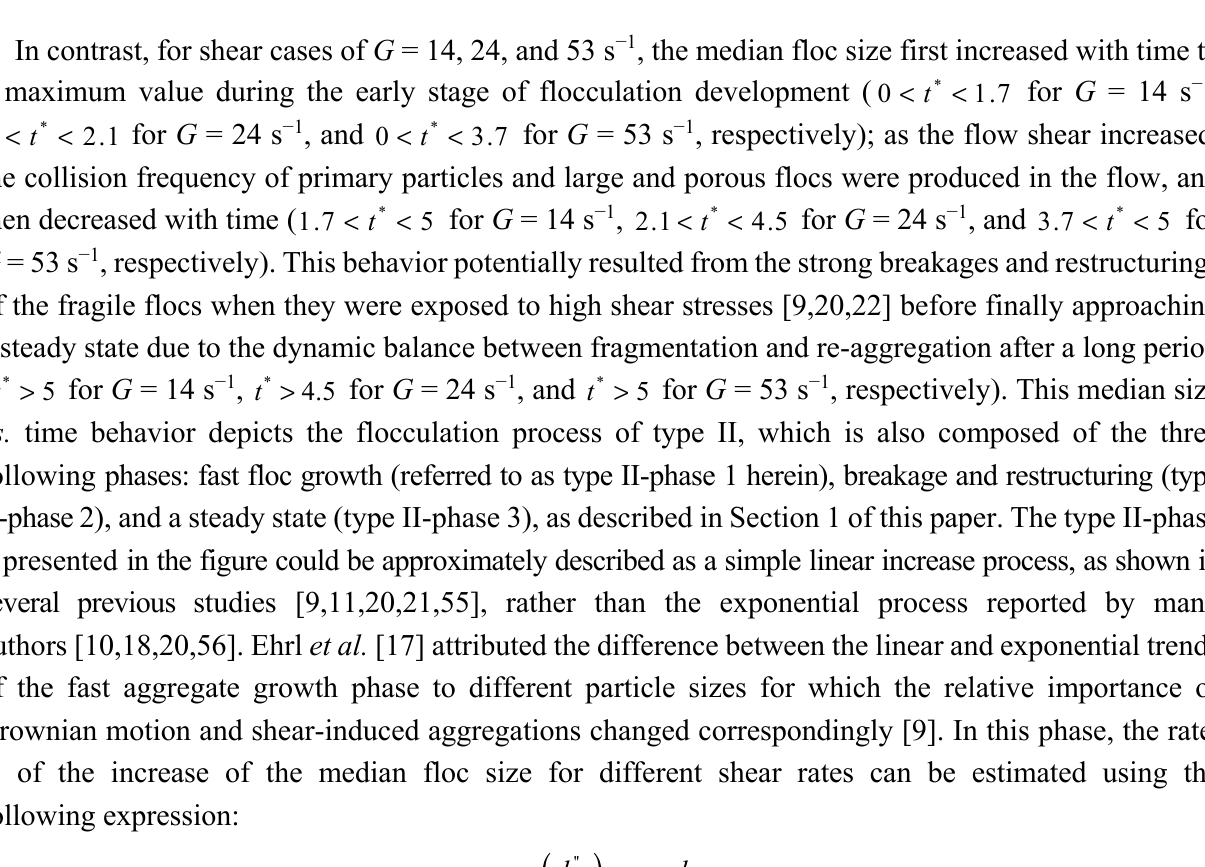
Figure 4. Evolution of the non-dimensional median flocsize of the flocs d with the non-dimensional flocculation time * t for different shear rates at φ = 7.87 × 10 − 5 without electrolyte added into the